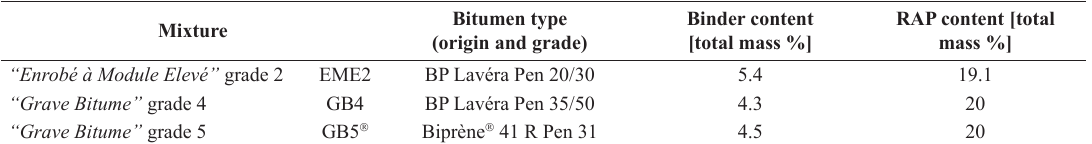
Table 1. Characteristics of the tested mixtures.